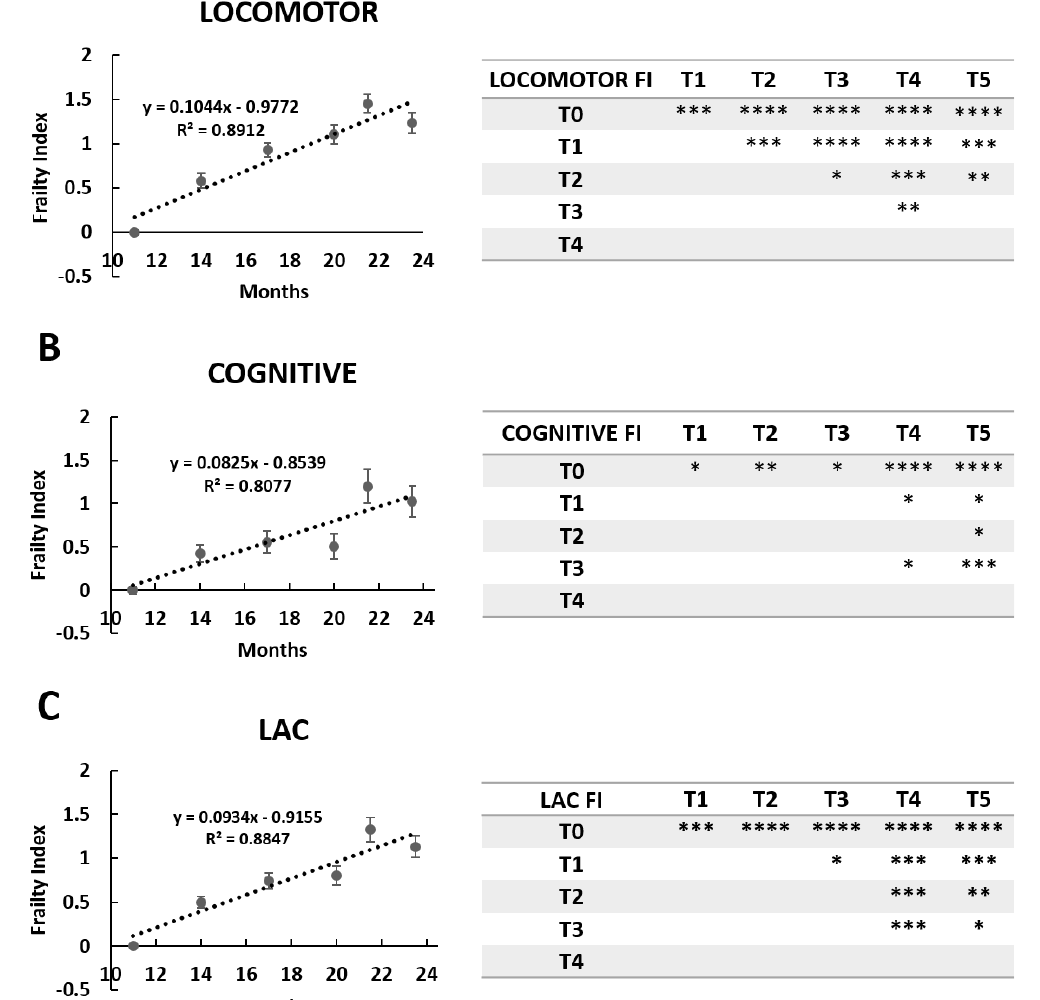
Figure 2B,C show the cognitive parameters measured in emergence and in NOR, respectively.